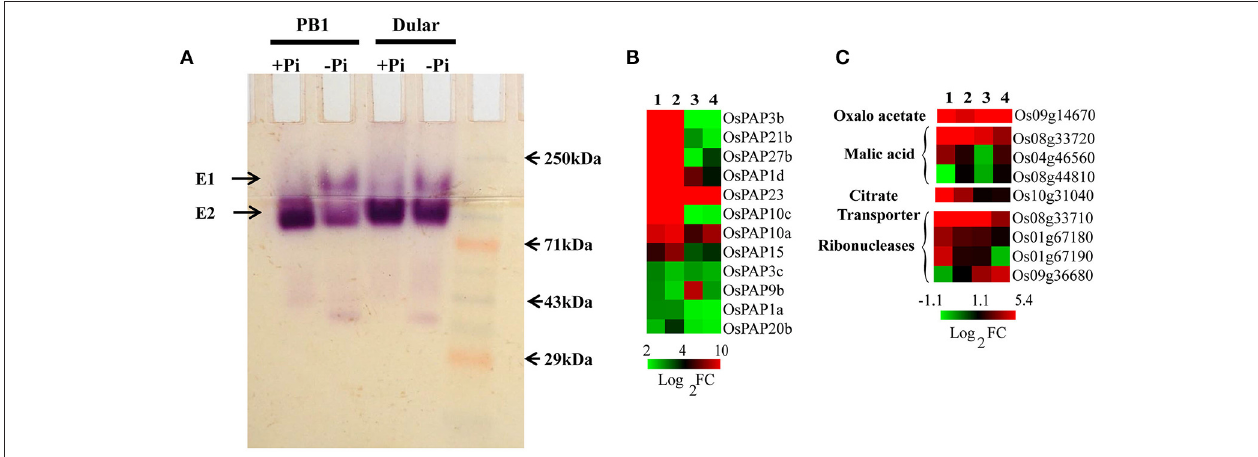
FIGURE 5 | Effect of Pi deficiency on APases and genes involved in organic acids metabolism. (A) In-gel APase activity of proteins extracted from PB1 and Dular roots under + Pi and -Pi conditions. (B) Expression profile of APases showing higher expression of APases in Dular and PB1 under + Pi and -Pi. (C) Differential expression of genes involved in organic acid metabolism in Dular and PB1 under Pi deficiency. 1, Dular root; 2, PB1 root; 3, Dular shoot; 4, PB1